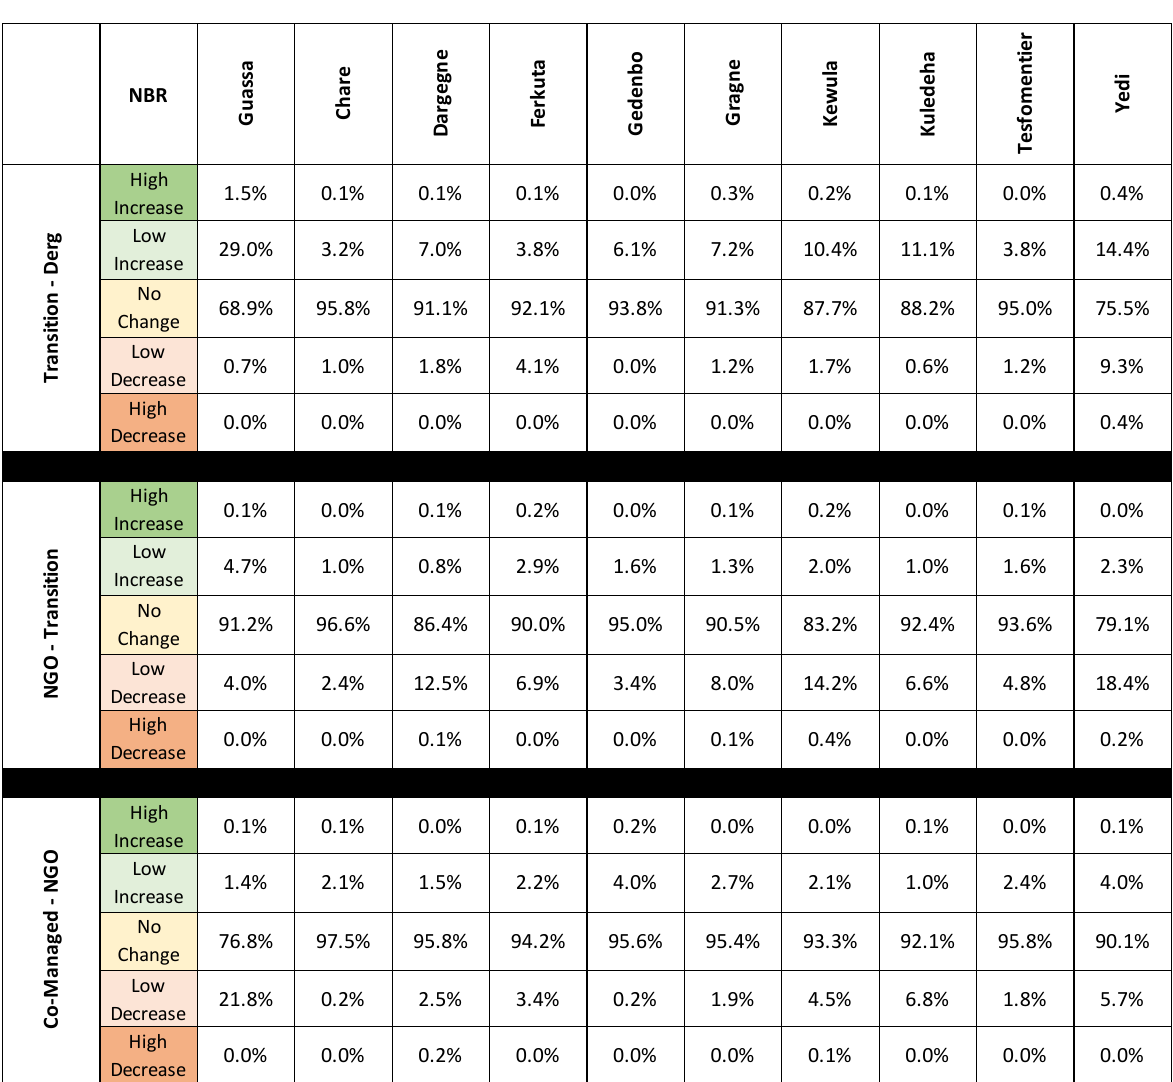
Table A1.4. The percent of land area and direction of vegetation change (from NBR values) for each kebele and the Guassa area across each period of political and management history (dry